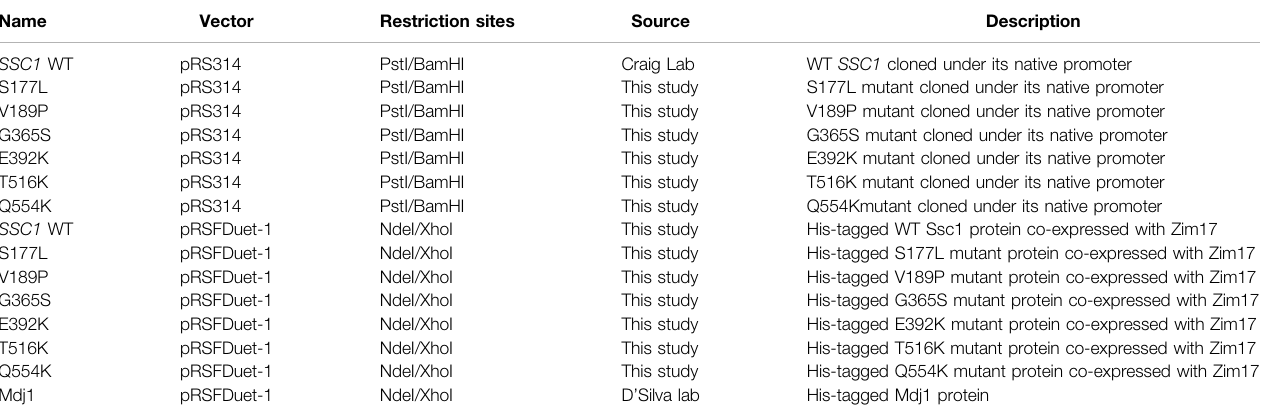
TABLE 3 | List of plasmid constructs used in the